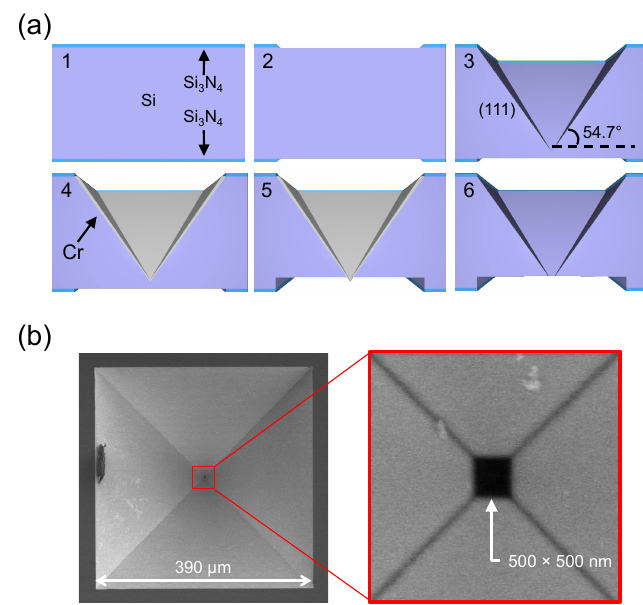
Figure 7. Fabrication process for the Si 3 N 4 /Si-based IP-shaped nanopore structures and scanning electron microscope (SEM) images of the nanostructures. ( a ) Schematic illustrations of the fabrication process. The two-step etching processes (No. 3 and 5) enabled us to fabricate the nanostructures without electron beam lithography. ( b ) SEM images of the Si 3 N 4 /Si-based IP-shaped nanopore structures with D / d = ca. 1000 fabricated using the present method.